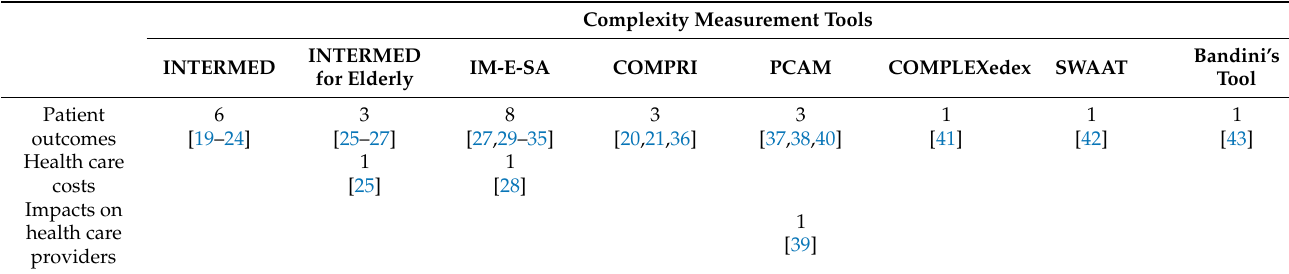
Table 3. Correlations between the measured complexity and